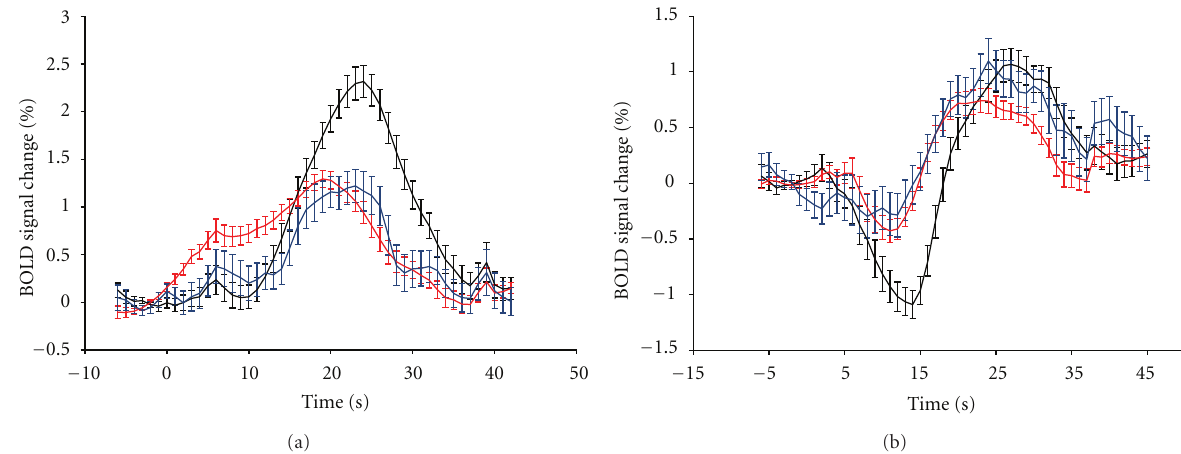
Figure 4: Average BOLD response to breath-holding of 15 seconds after (a) expiration and (b) inspiration on brain regions supplied by the three main cerebral arteries (anterior: blue, middle: red, and posterior: black), for a group of healthy subjects. Reproduced from Leoni et al.